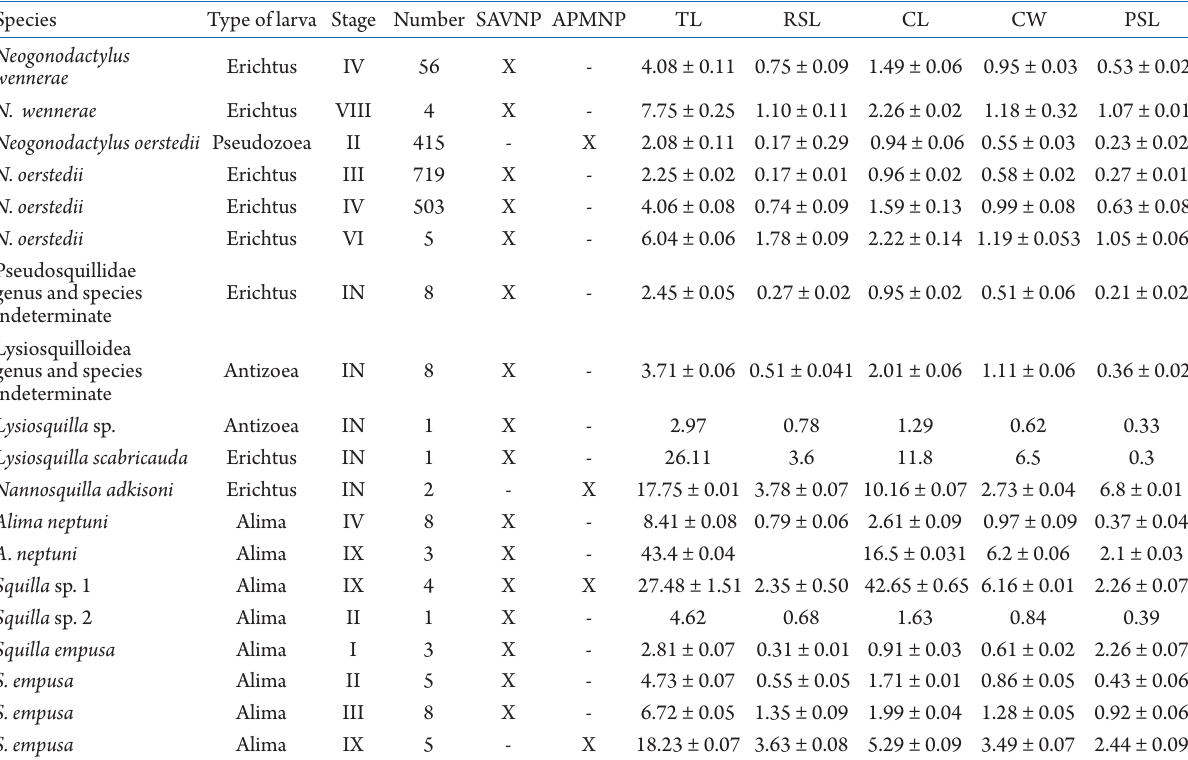
Table 1. Stomatopod larvae collected at the national parks Sistema Arrecifal Veracruzano (SAVNP) and Arrecife Puerto Morelos (APMNP) organized by species, larval stage, and type of larva. IN, indeterminate; X, presence; (-), absence. TL, total length; CL, carapace length; CW, carapace width; RSL, rostral spine length; posterolateral spines length